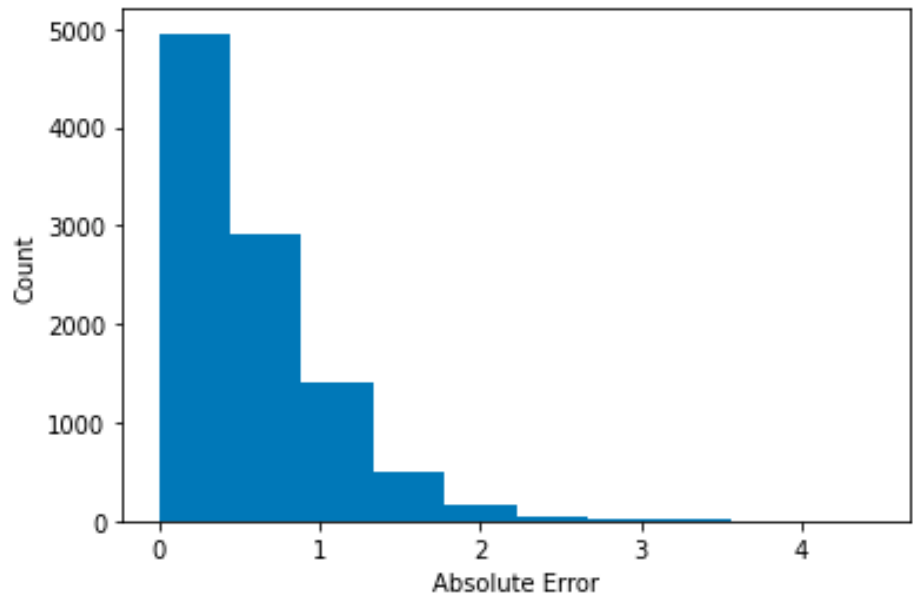
Figure 4. Boxplot of predicted ages according to their actual age group: the colored boxes indicate 25–75% of the age values predicted by the proposed model.